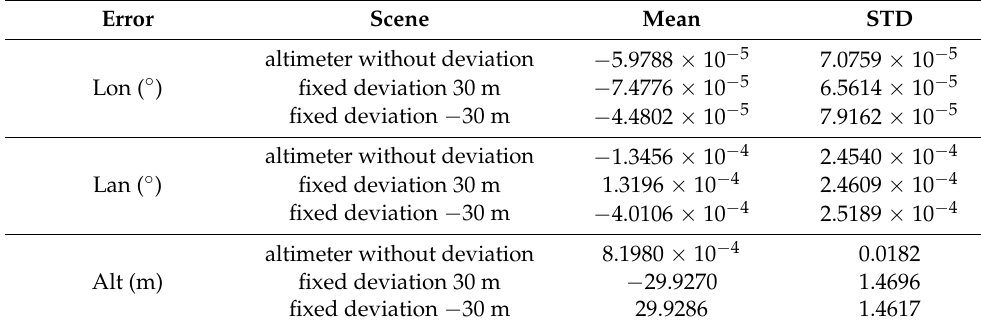
Table 5. Position error statistics.